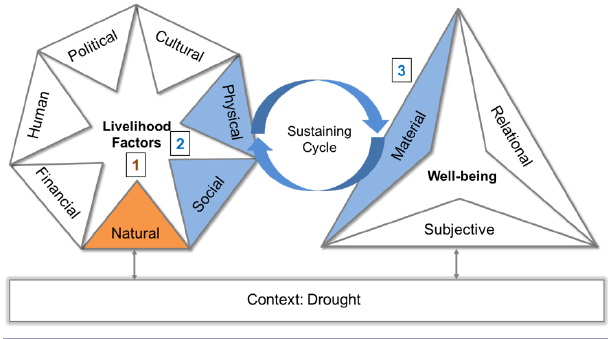
Fig. 7 . The integrated sustainable livelihoods approach and well-being framework for northeastern Colorado livestock producers illustrating a strategy of diversification, with orange depicting losses and blue indicating elements that gained or maintained. (1) First, drought hit the operation, and as a result, the natural factor was reduced, eliminating crops and reducing grazing. (2) Given the loss of natural resources, the producer used his physical factor of a feedlot and his social network to custom feed local producers’ cattle. (3) Despite the loss of grazing resources and crops, the producer’s vertical integration strategy in the cattle industry enabled the maintenance of material